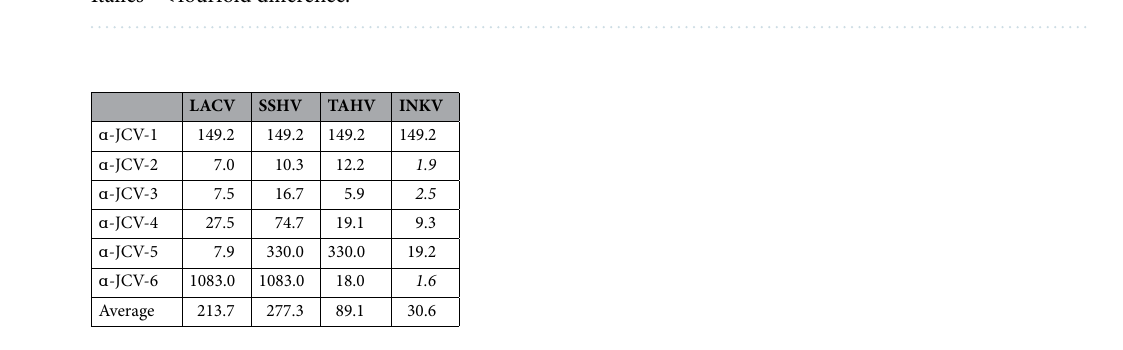
Table 6. ND50 fold difference of ɑ -JCV plasma between heterologous viruses vs. homologous JCV. Italics = < fourfold